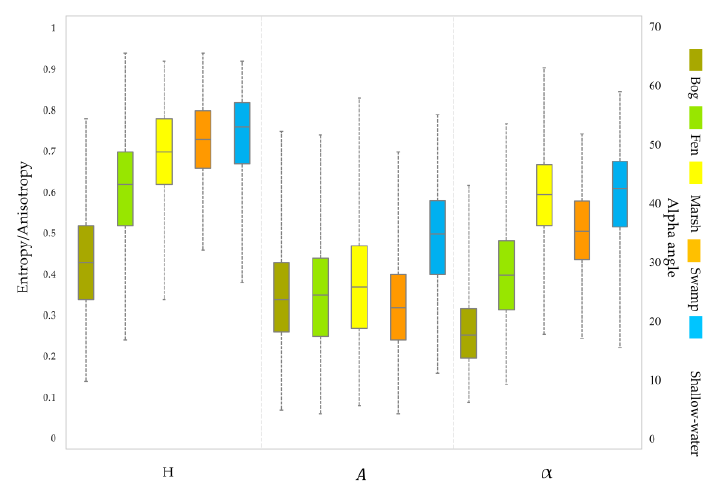
Figure 5. Box-and-whisker plots for extracted features from the Cloude-Pottier decomposition for wetland classes obtained from the pixel values of the training data set. Note: H: entropy, A: anisotropy, and α : alpha angle.